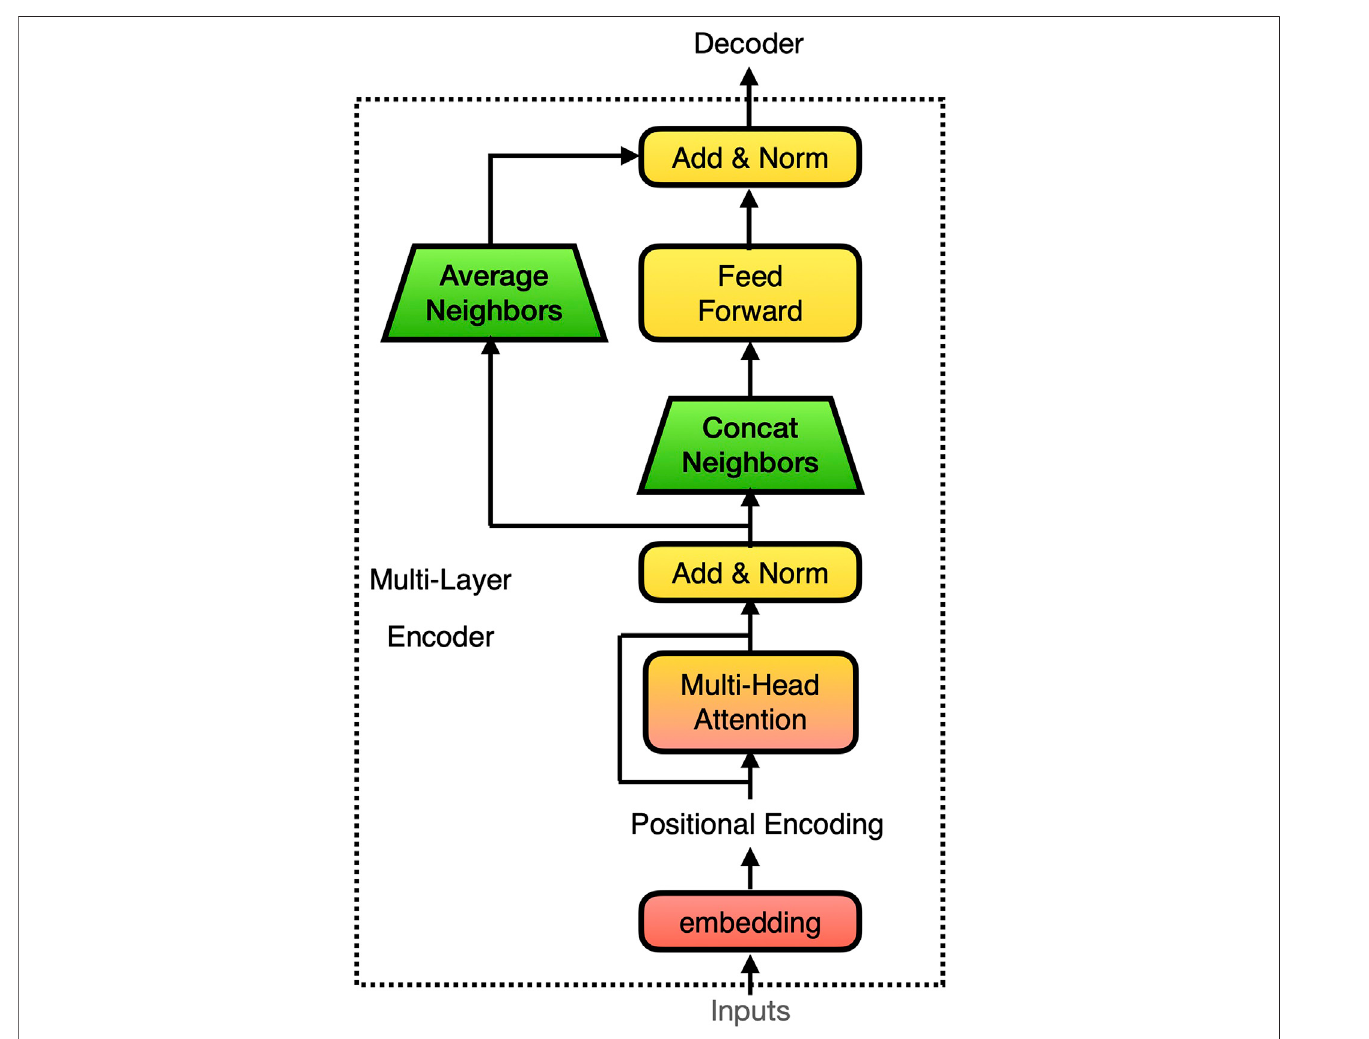
FIGURE 3 | The implementation of pyramid structure in Transformer ’ s